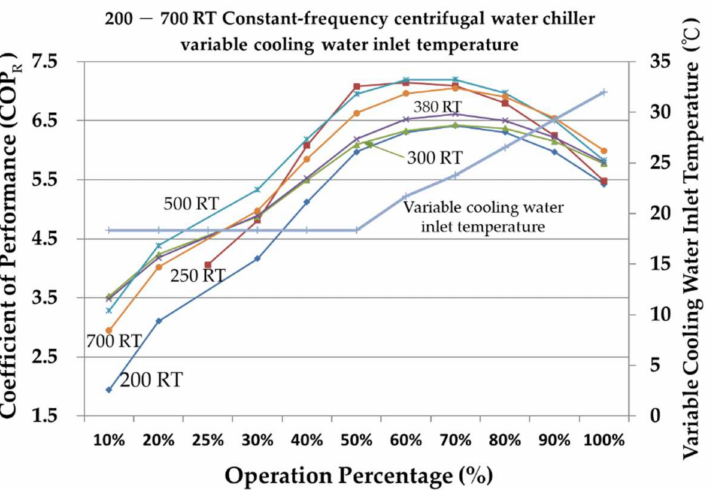
Figure 13. Variable-cooling water inlet temperature COP R of the 200–700 RT constant-frequency water chiller.